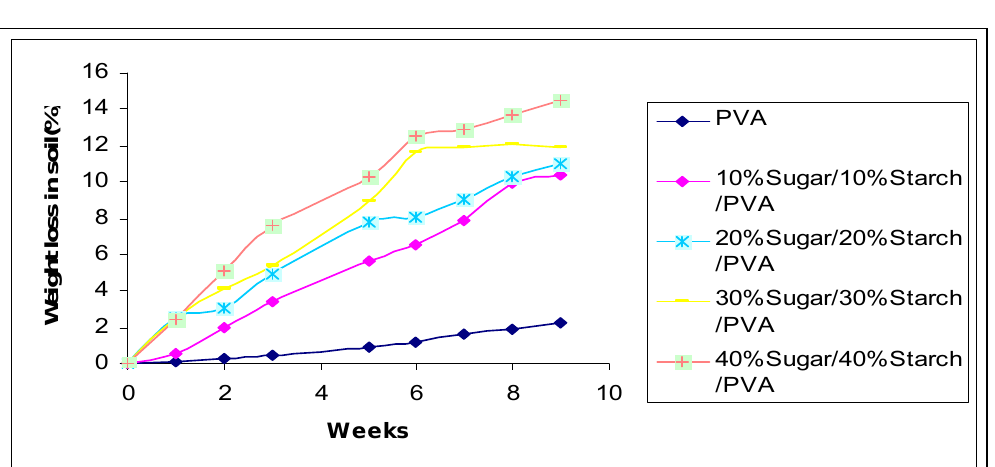
Fig. 16: The weight loss with the soil burial time at 13cm depth for the of PVA, and Starch/PVA/sugar at different